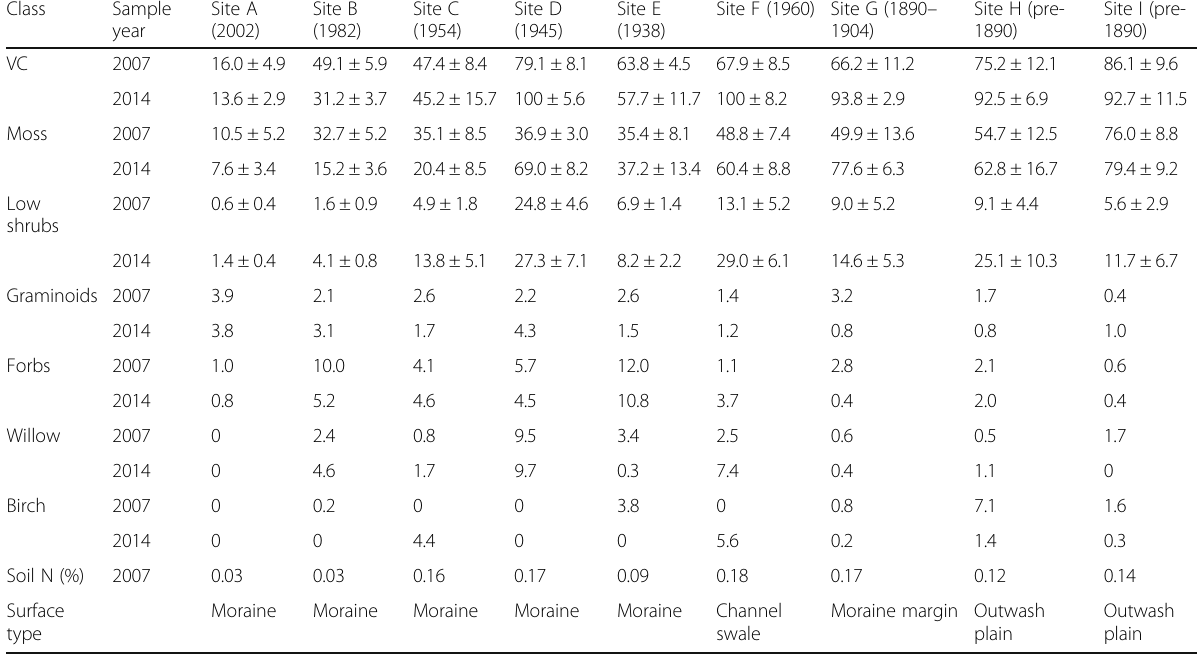
Table 2 Total vegetative cover (VC), % cover by vegetation groups and site characteristics, 2007 compared to 2014 (with standard error for major groups). See text for explanation of the estimated site